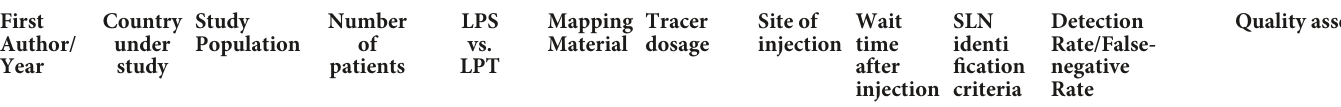
TABLE 1 Characteristics of the studies ( N =